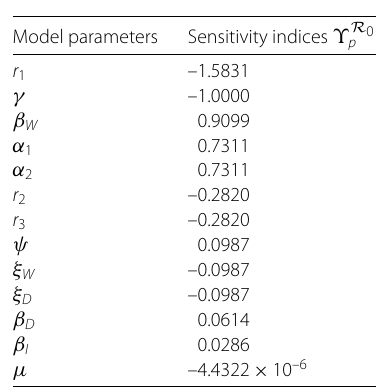
Table 4 Sensitivity indices of R 0 to model parameters for model (3.2), evaluated at the baseline parameter values given in Table